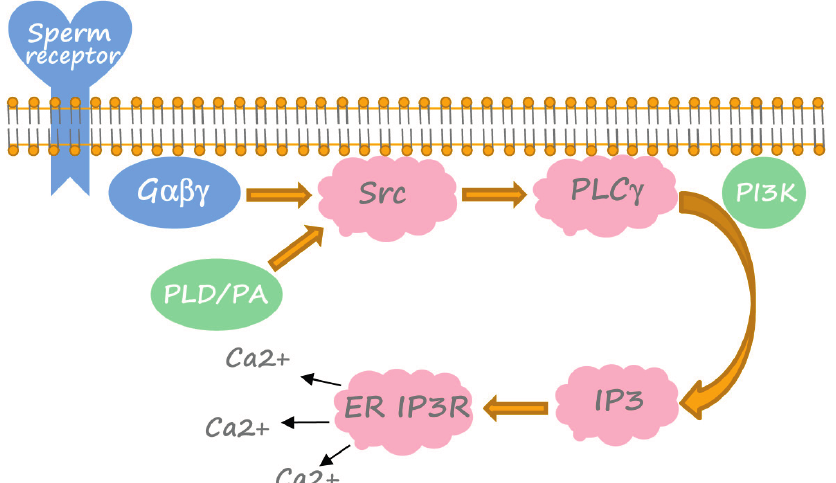
Figure 2. Fertilization-induced cascade of intracellular calcium release in Xenopus